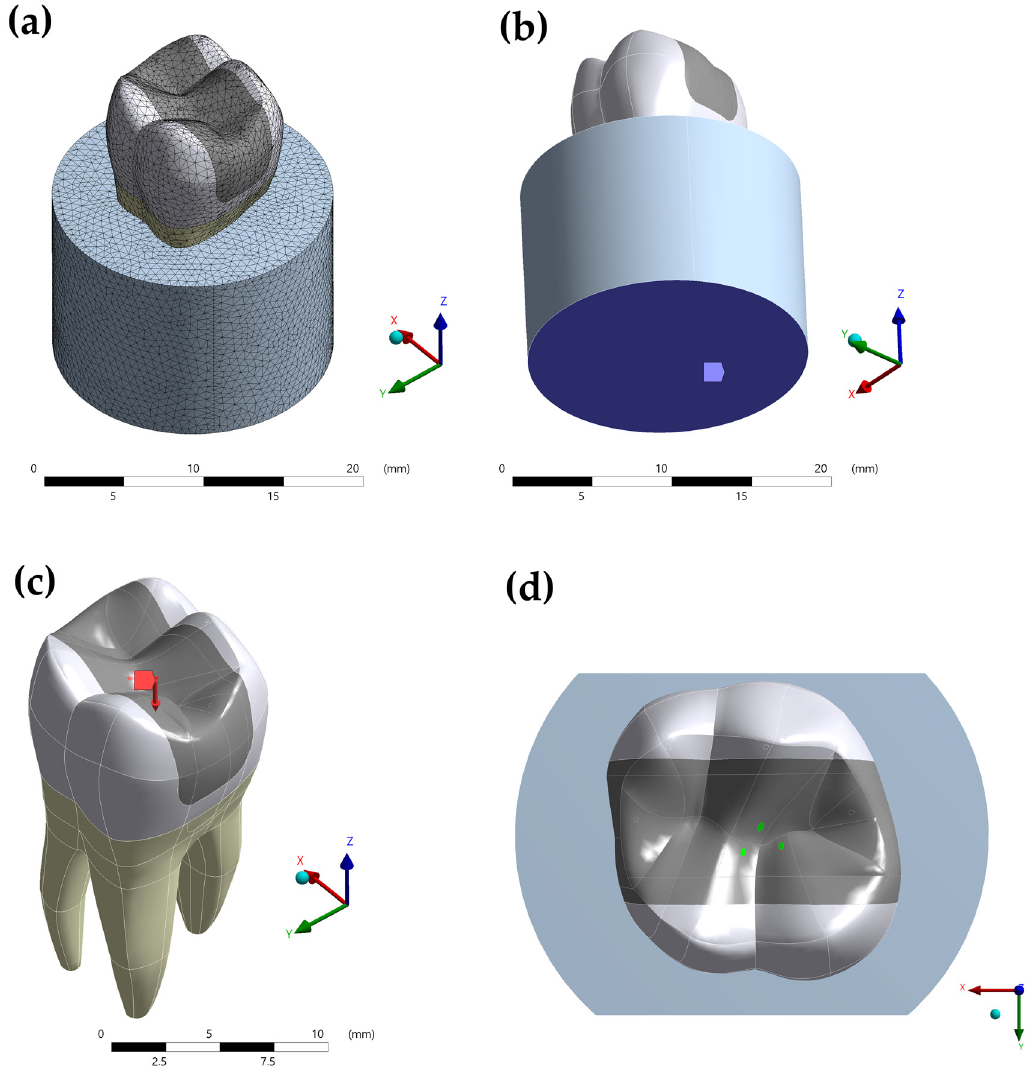
Figure 3. Boundary condition in the present simulation. ( a ) Mesh generation; ( b ) fixation of the system; ( c ) loading settings; ( d ) tripod contact area.